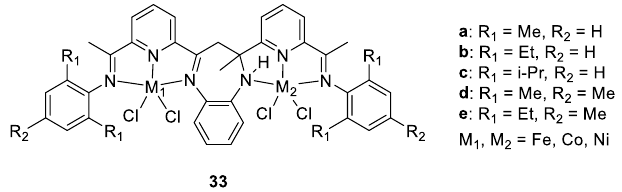
Figure 19. Homo- and hetero-bimetallic iron and cobalt complexes.